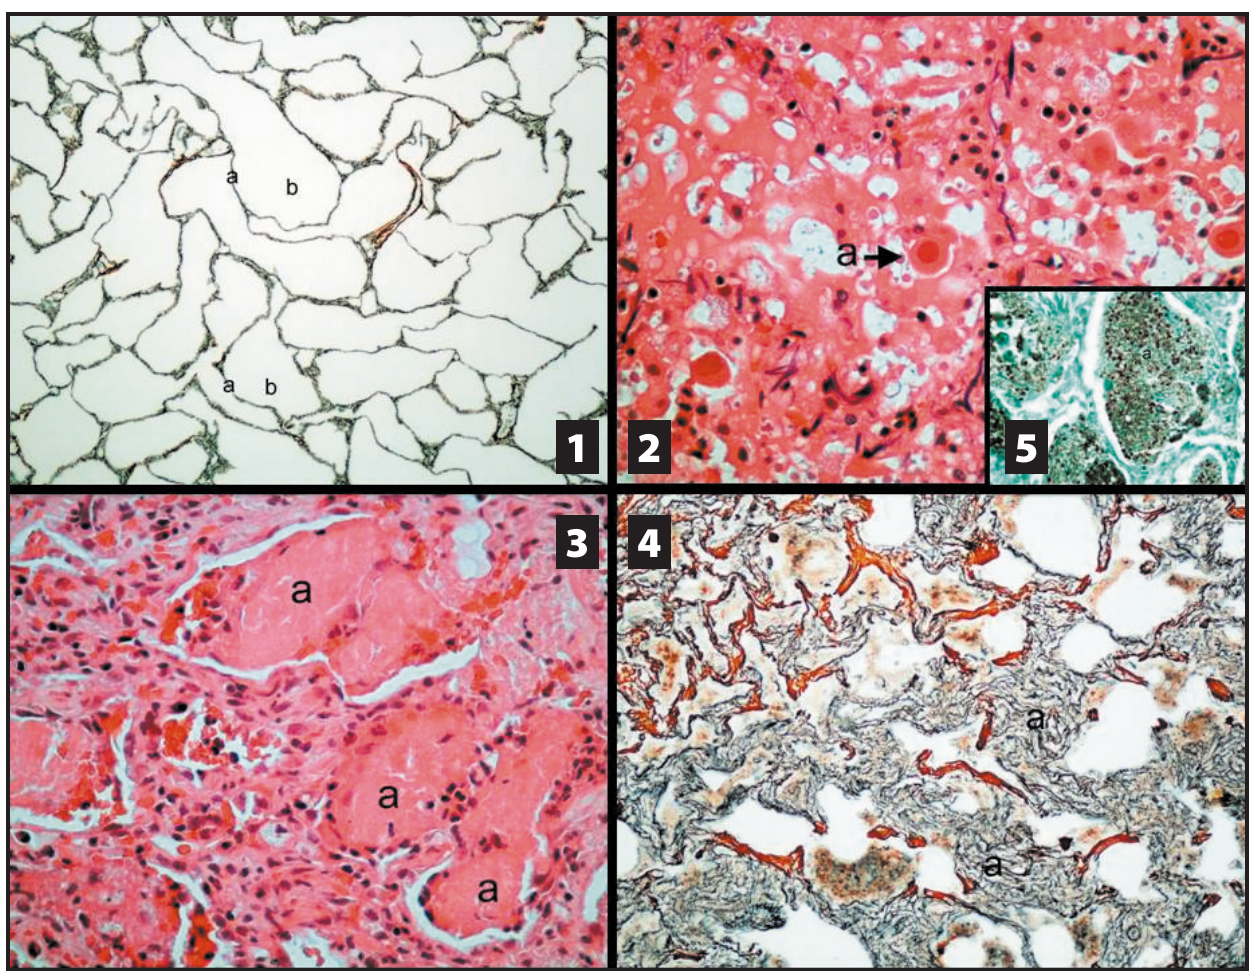
Fig. 1. Low magnification of alveoli showing normal interstitium of (a) alveolar walls and (b) alveolar spaces (Gordon and Sweet stain). Fig. 2. High magnification showing an enlarged pneumocyte with (a) an intranuclear CMV inclusion (haemotoxylin and eosin stain). Fig. 3. Low magnification showing (a) frothy exudate filling the alveolar spaces (haemotoxylin and eosin stain). Fig. 4. Low magnification showing (a) marked expansion of the interstitium by fibrous tissue (Gordon and Sweet stain). Fig. 5. Higher magnification showing pneumocystis organisms within frothy intra-alveolar exudates (Grocott